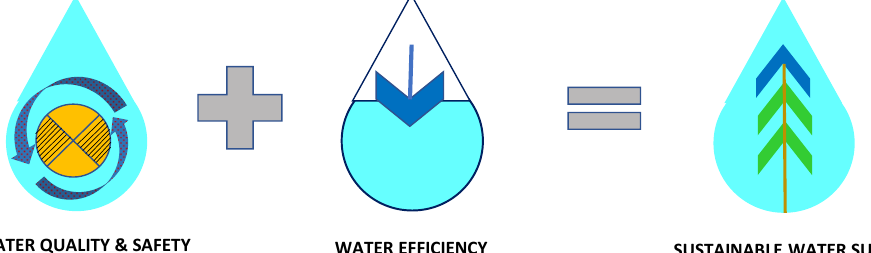
Figure 1. Conceptual framework of achieving a sustainable water system.